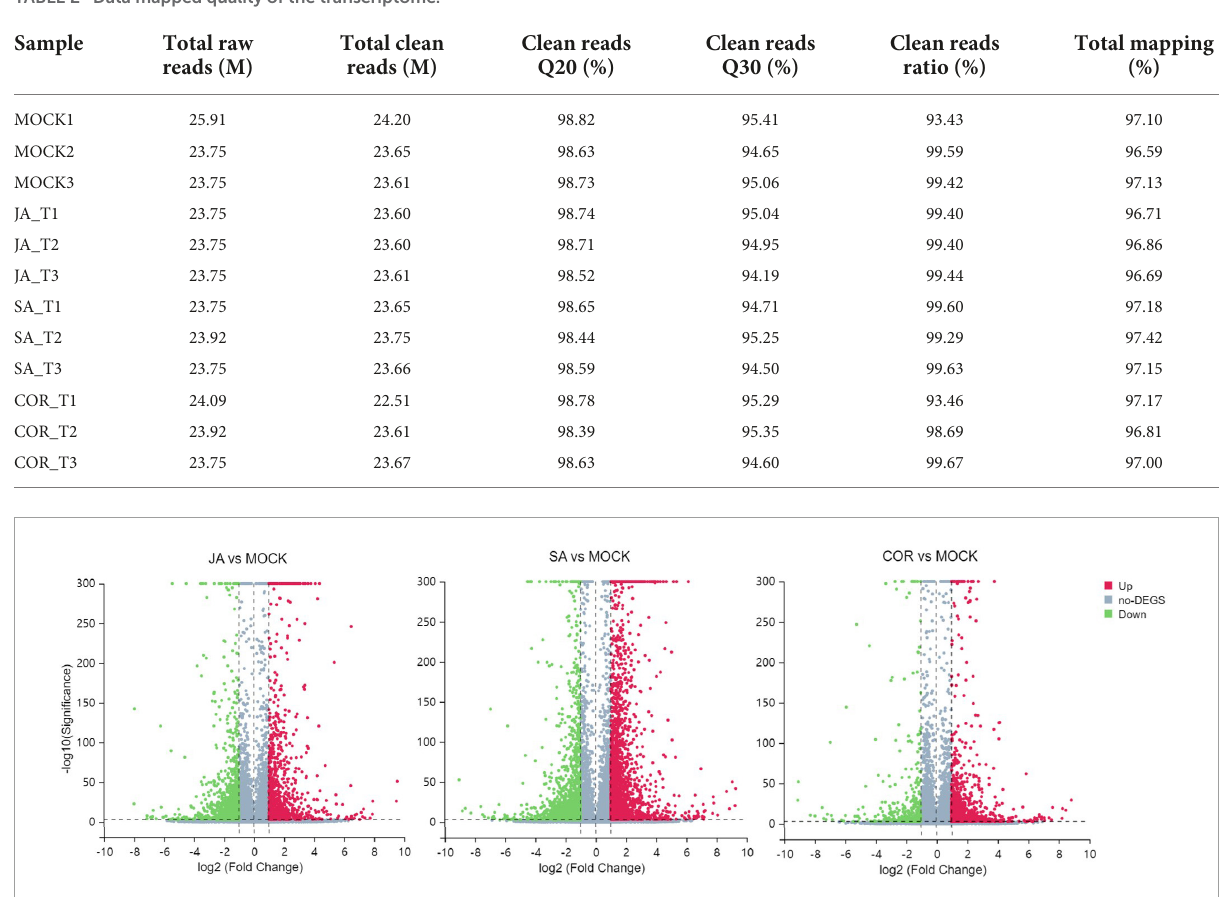
TABLE 2 Data mapped quality of the transcriptome.